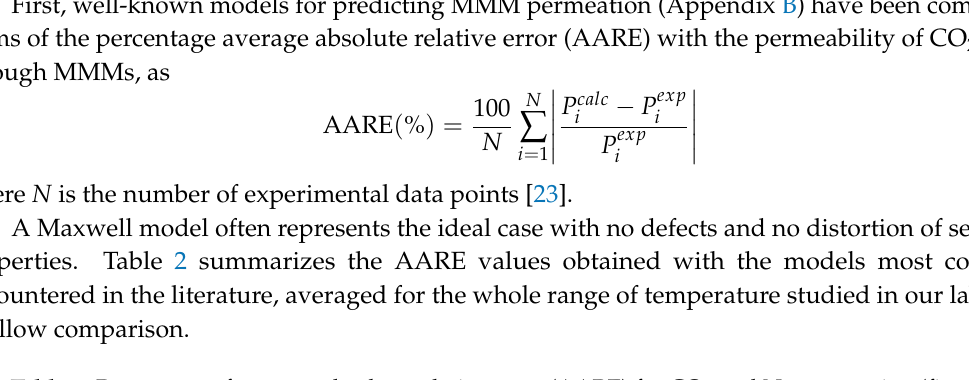
Table 2. Percentage of average absolute relative error (AARE) for CO 2 and N 2 permeation (first and second values in every entry) prediction, highlighting those AARE values lower than 20%.